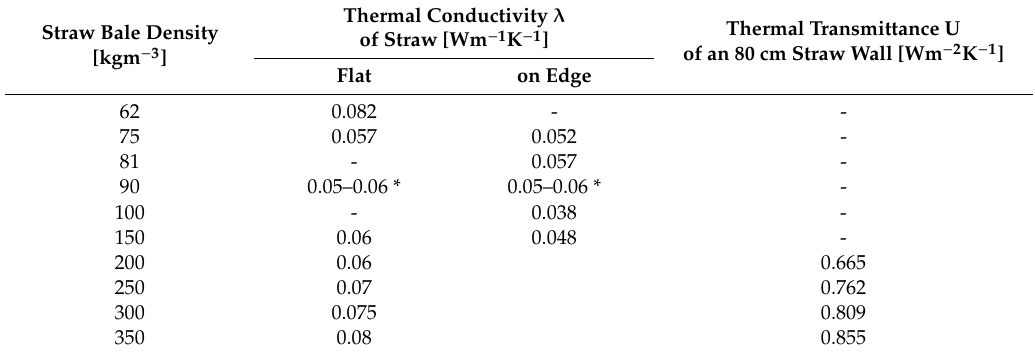
Table 1. Thermal characteristics of straw [8–10].